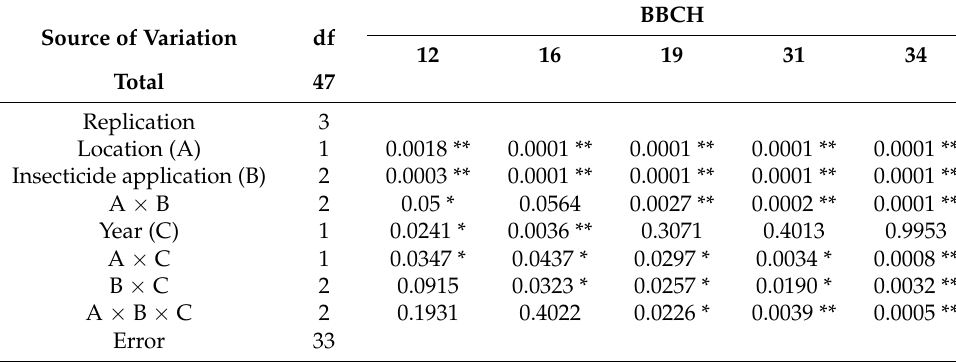
Table 2. Factorial analysis (ANOVA) of the plant density in different developmental stages of the beets.